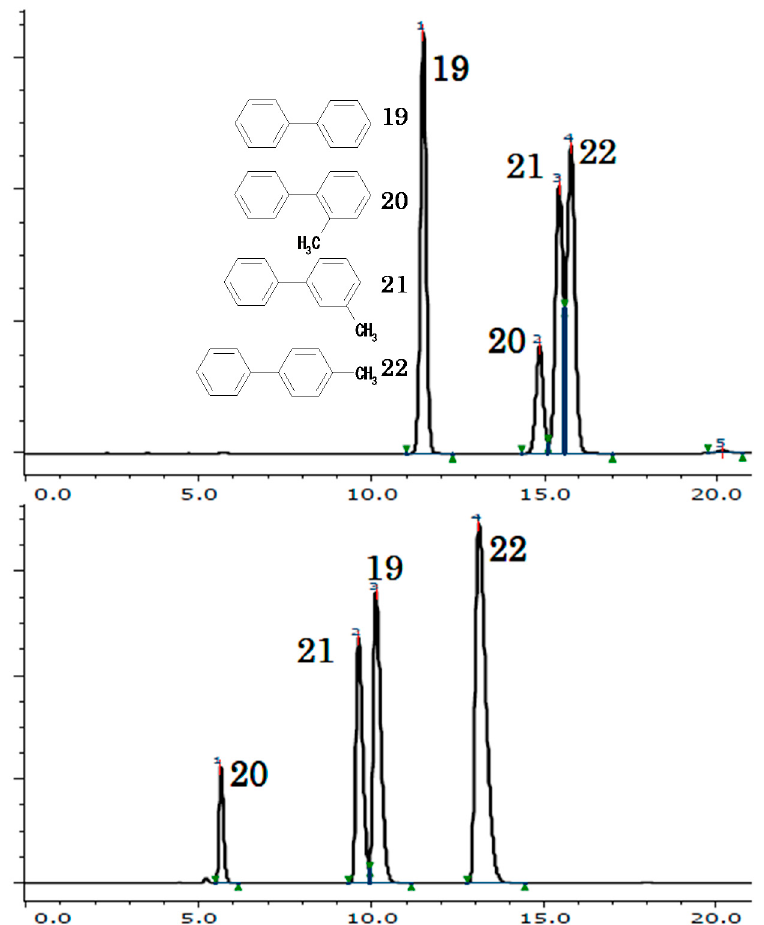
Figure 6. Chromatograms of biphenyl ( 19 ) and three methylbiphenyl isomers, 2-methylbiphenyl ( 20 ), 3-methylbiphenyl ( 21 ), and 4-methylbiphenyl ( 22 ). Upper : On L-Column ® with acetonitrile/water mixture (70:30 v / v ). Lower : On CHIRALCEL ® OJ-H with hexane/2-propanol mixture (100:1 v / v ), 1.0 mL/min.